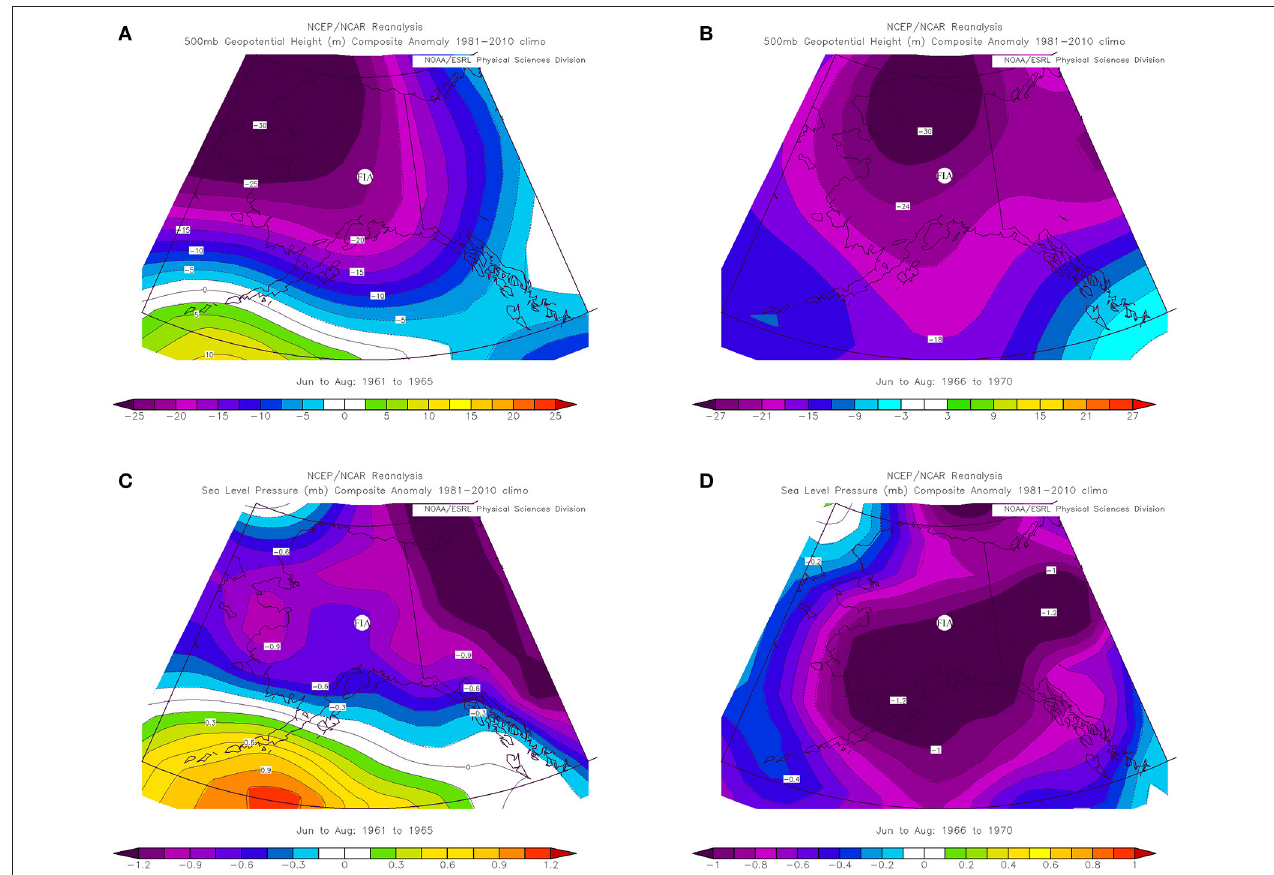
FIGURE 7 | Composite anomaly 500 mb geopotential height for (A) Five year before change (1961–1965), and (B) Five year after change (1966-1970); Composite anomaly Sea Level Pressure (SLP) measured in millibars (mb) for (C) Five year before change (1961–1965), and (D) Five year after change (1966–1970) for summer months June-Aug at FIA station